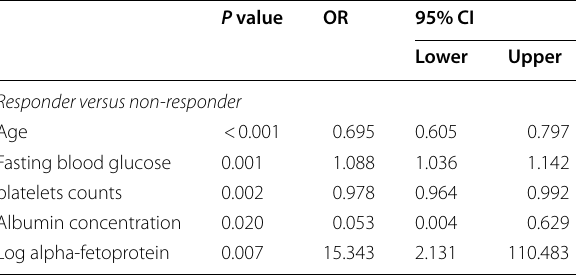
Table 5 Stepwise binary logistic regression for clinical data